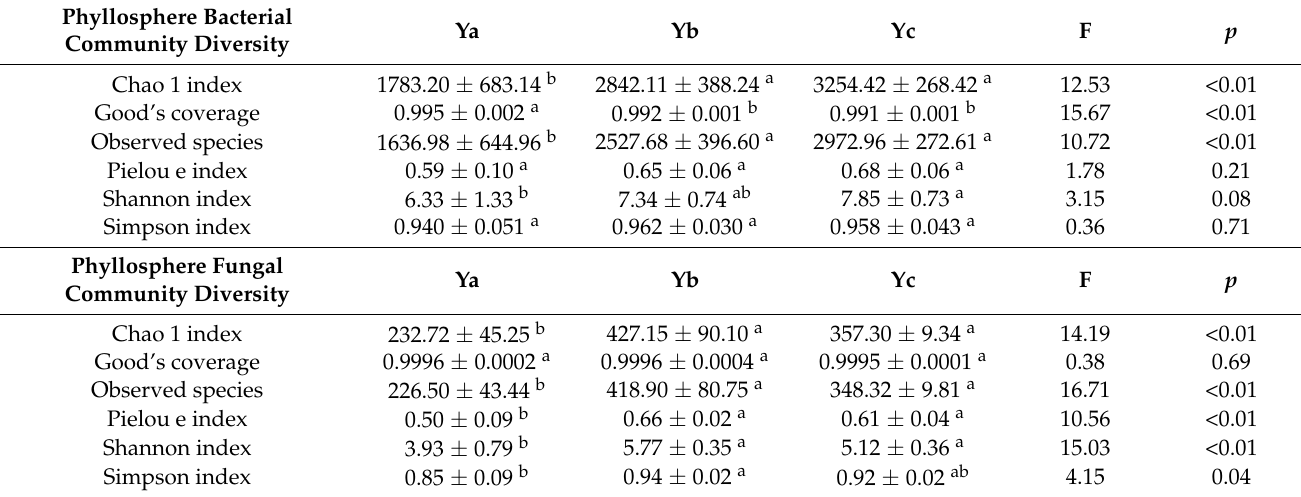
Table 2. Phyllosphere bacterial and fungal community diversity among Ya, Yb, and